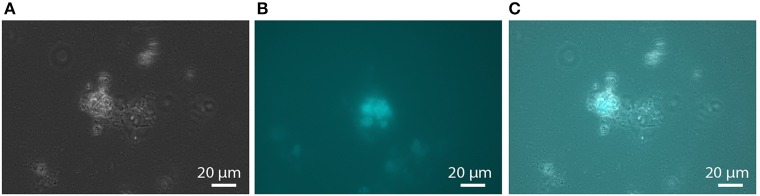
F420 fluorescence of aggregated biomass in the nitrate-AOM enrichment culture. (A) phase contrast micrograph, (B) fluorescence micrograph with an excitation wavelength of 390 nm and an emission wavelength of 420 nm, (C) overlay of the phase contrast and the fluorescence micrograph showing that not all cells in the aggregates exhibit F420 fluorescence.